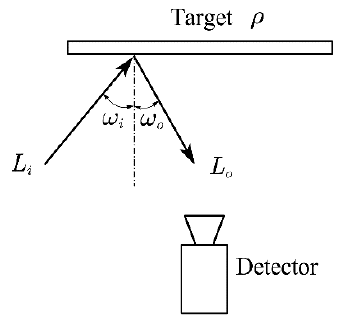
Figure 3. Radiances reflected by a curved surface are not equal.